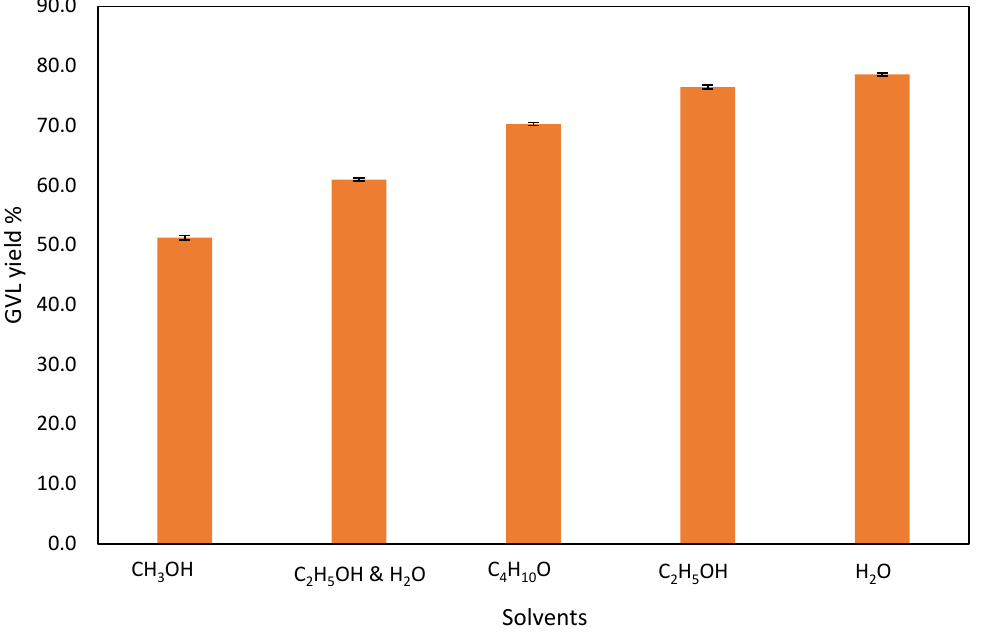
Figure 6. E ff ect of solvents on the GVL production from commercial LA. Figure 6. Effect of solvents on the GVL production from commercial